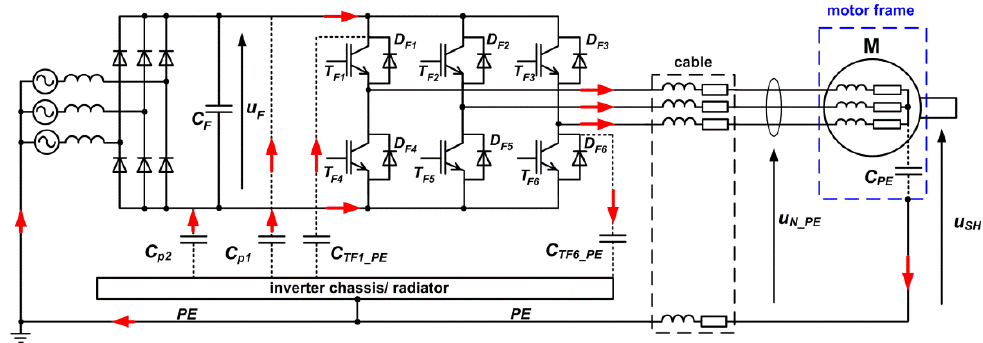
Figure 2. Common-mode currents’ propagation paths in electric drive fed by the voltage inverter (ground capacitances of transistors T F1 and T F6 are marked).